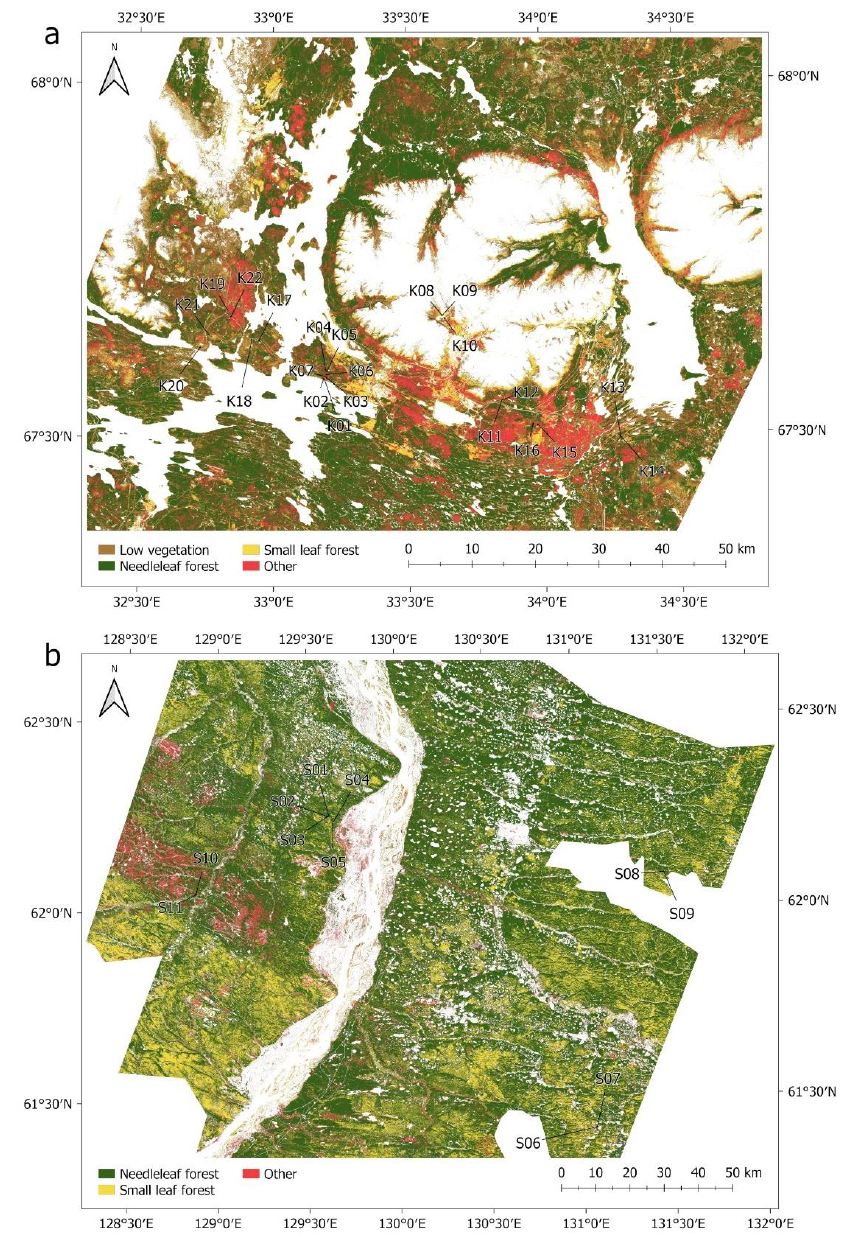
Figure 5. Generalised forest-cover map of the study areas. Non-forest areas are masked out. ( a ) Khibiny; ( b ) Sakha. Site locations are identified. ( a ) Khibiny; ( b ) Sakha. Site locations are